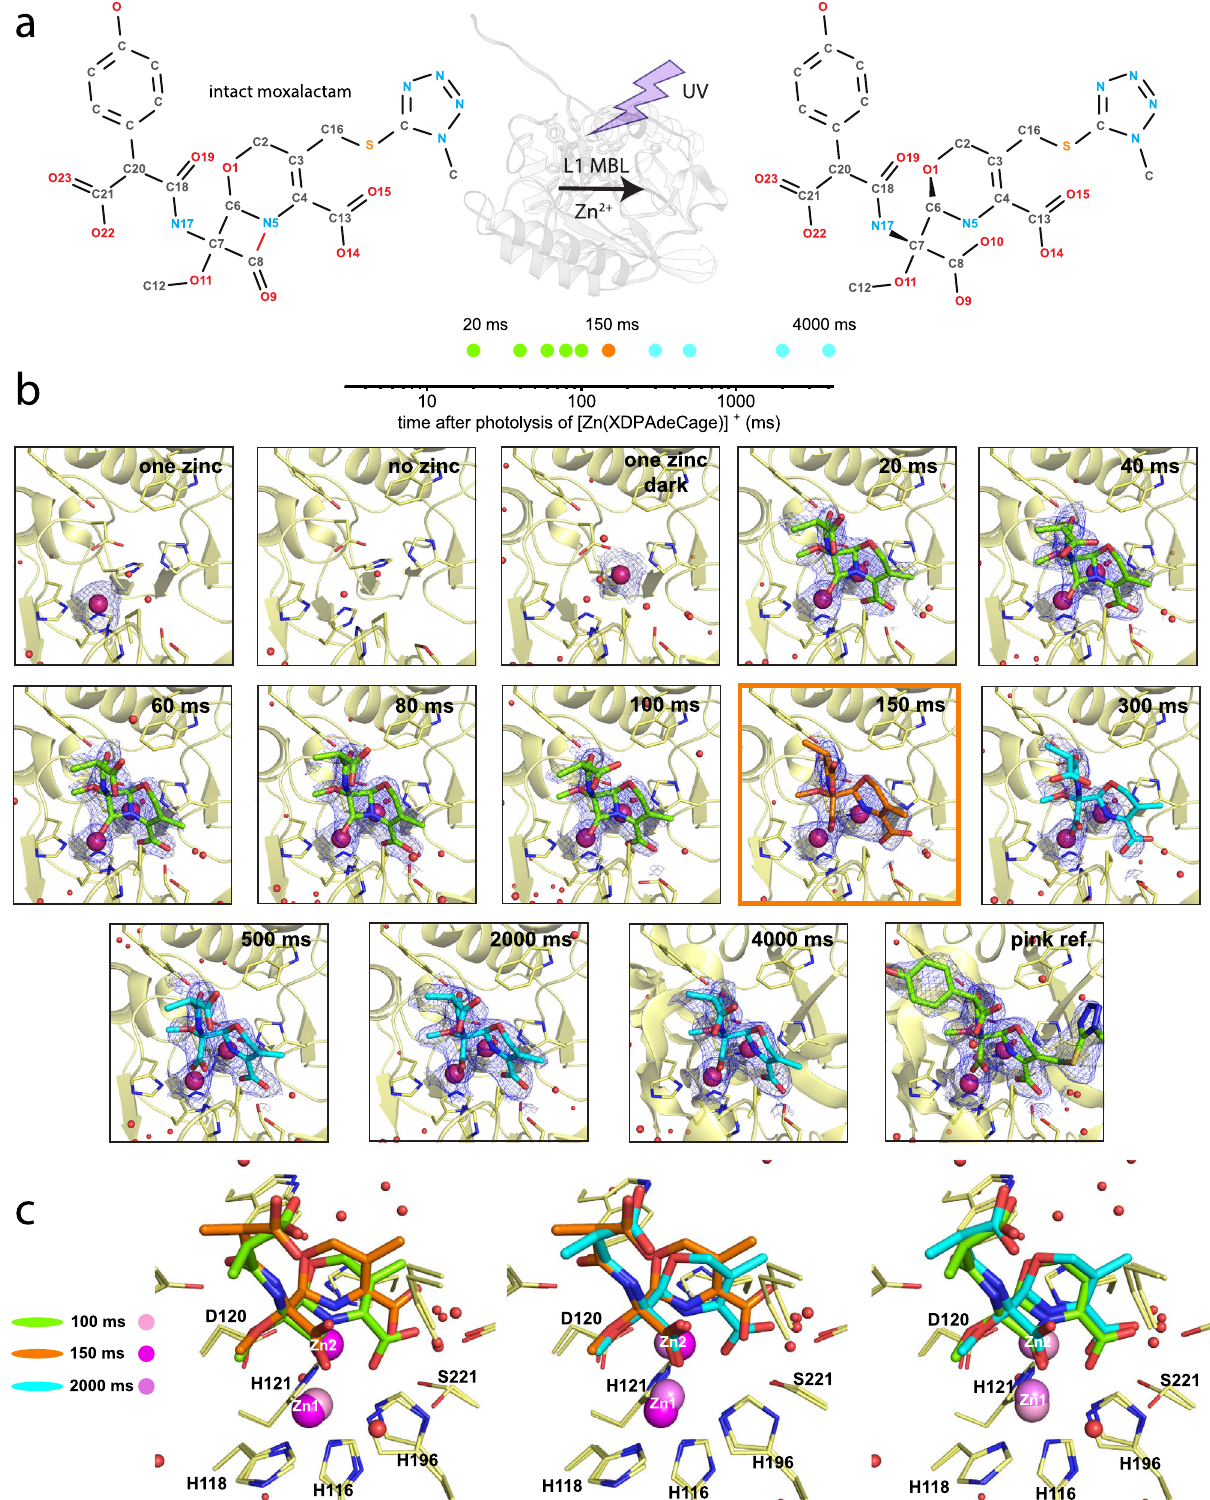
σ level(carvedat1.4Å)aroundmoxalactamandzincionsincatalyticsiteofL1MBL. c Substrate,intermediateandproductofmoxalactamhydrolysisbyL1areshownat three time points. Representation of three key steps captured during reaction (100ms bound uncleaved moxalactam – substrate (green), 150ms hydrolyzed moxalactam intermediate (orange), 2000ms structure with hydrolyzed mox- alactam after reaction – product (aqua)). Legend on left site of image illustrates shades of pink spheres that visualize zinc